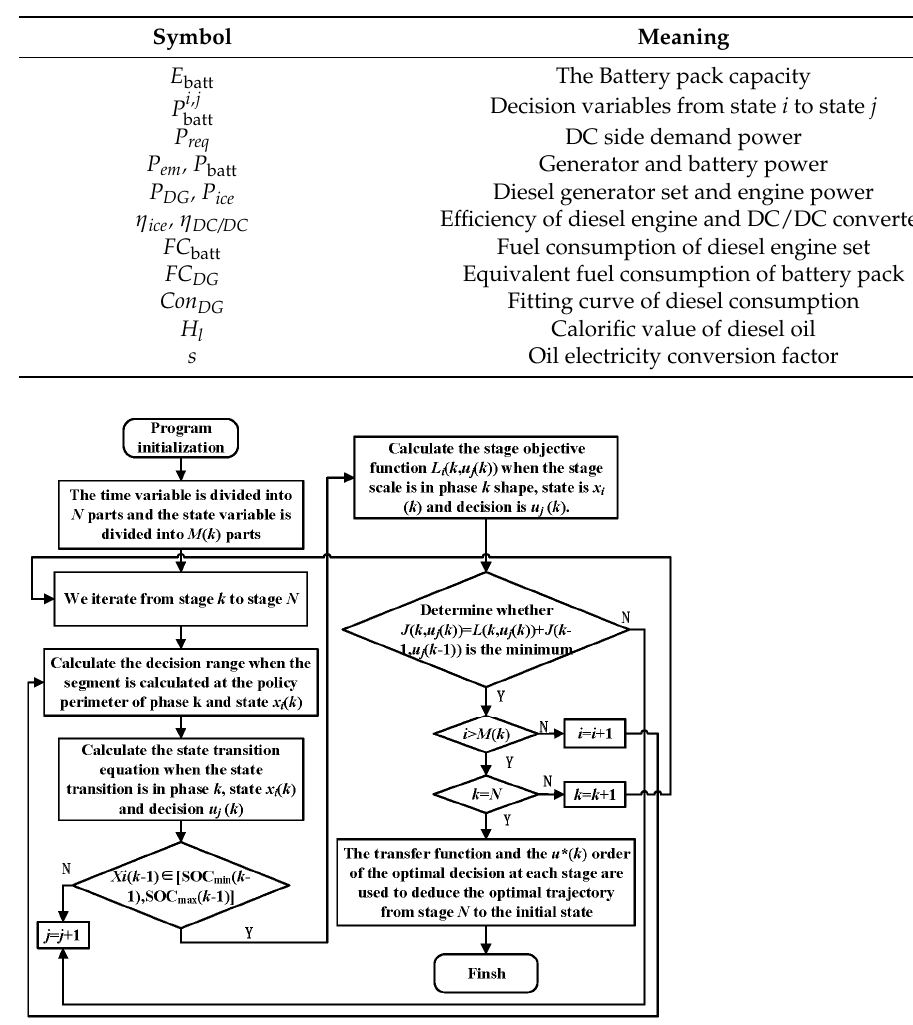
Table 1. Nomenclature.